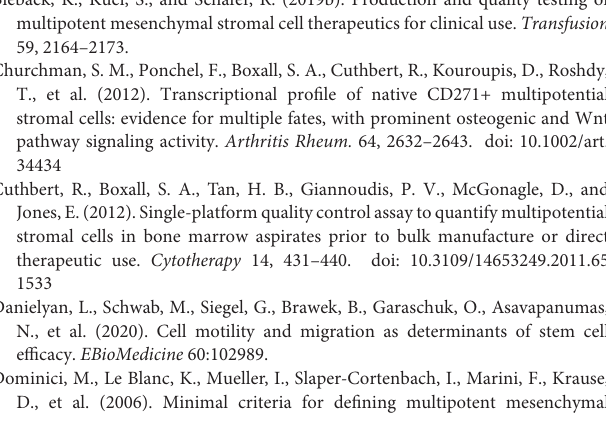
Supplemental Figure 1 | MSC surface marker phenotyping. Flow cytometry analyses of typical MSC markers, HLA class II, and hematopoietic markers at P1 and P2 (A) . Data are presented as means ( n = 2 donors). Error bars: SD. Prevalence of MSC subpopulation markers identified and quantified by multicolor flow cytometry at P1 (B) and P2 (C) . Data are presented as means ( n = 2 donors). Error bars: